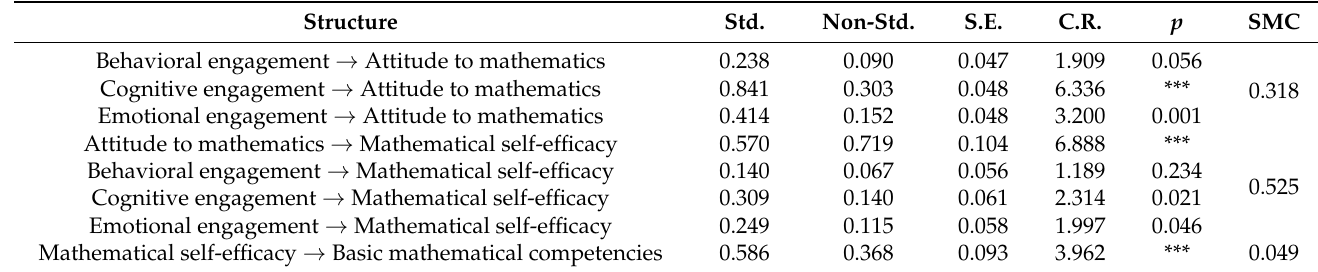
Table 5. Path coefficients in the structural model.